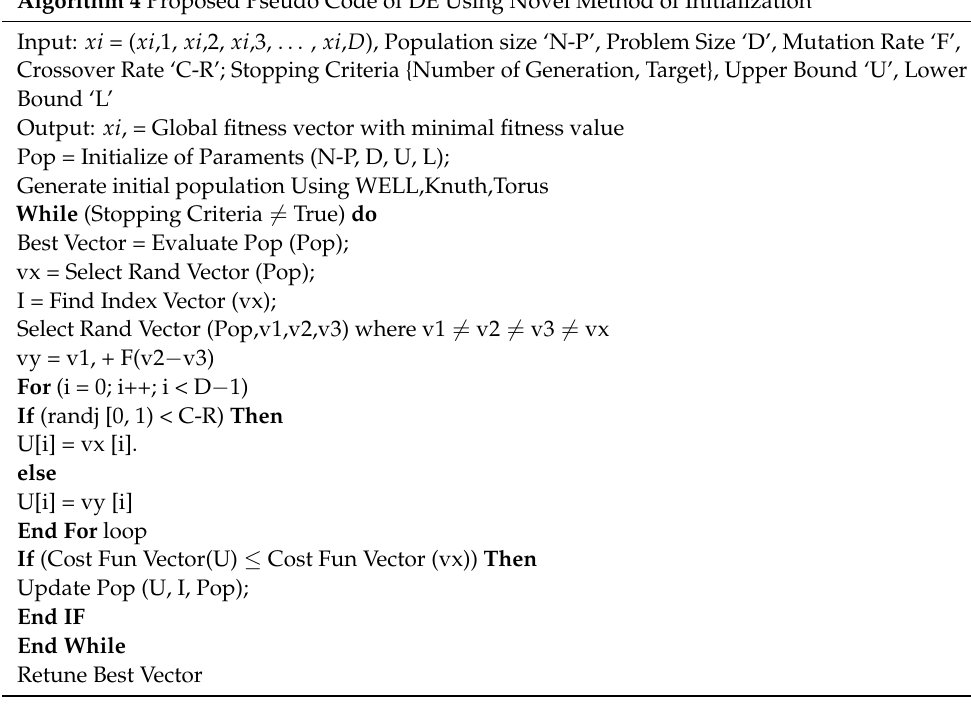
Algorithm 4 Proposed Pseudo Code of DE Using Novel Method of